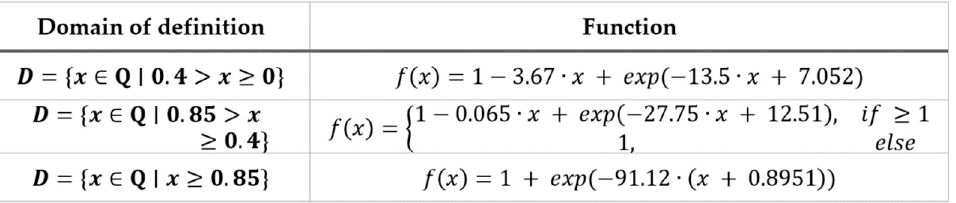
Figure 11. Degradation curve at different cell voltages for an FC (own figure based on [17]).